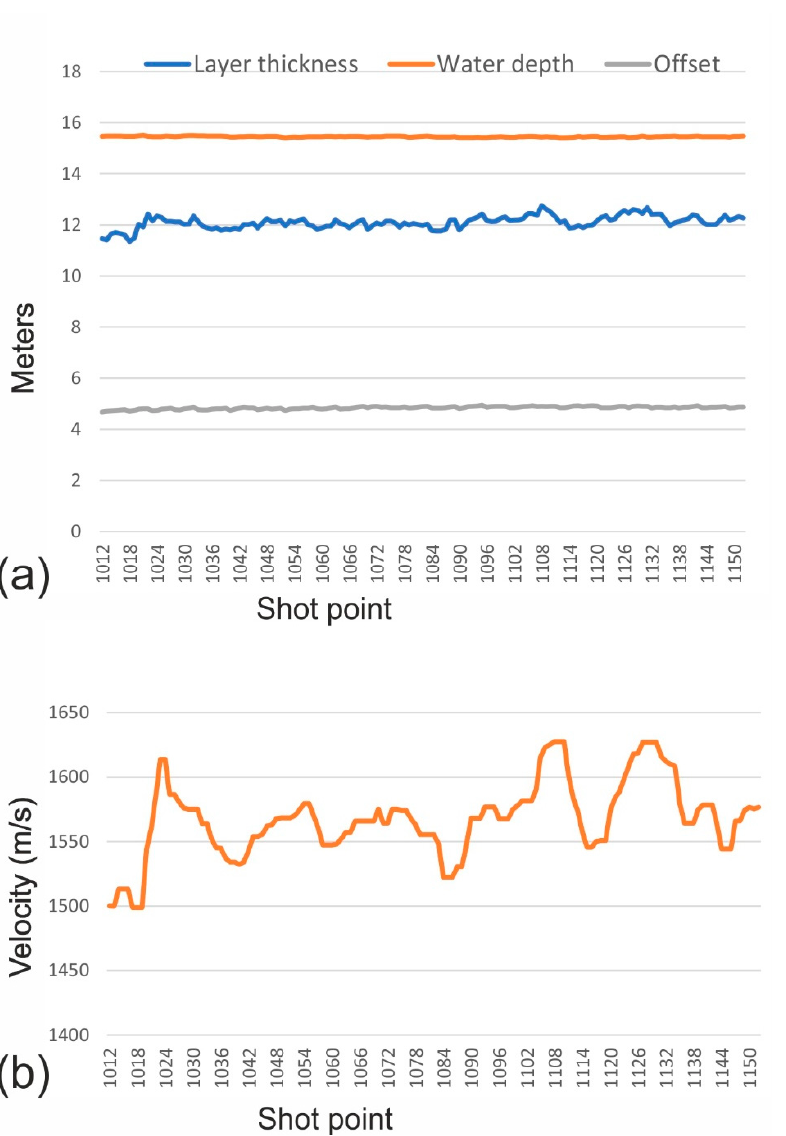
Figure 7. Estimation results: ( a ) layer thickness (blue line), water depth (orange line), and offset (grey line); ( b ) layer velocity after a 5-term median filter.